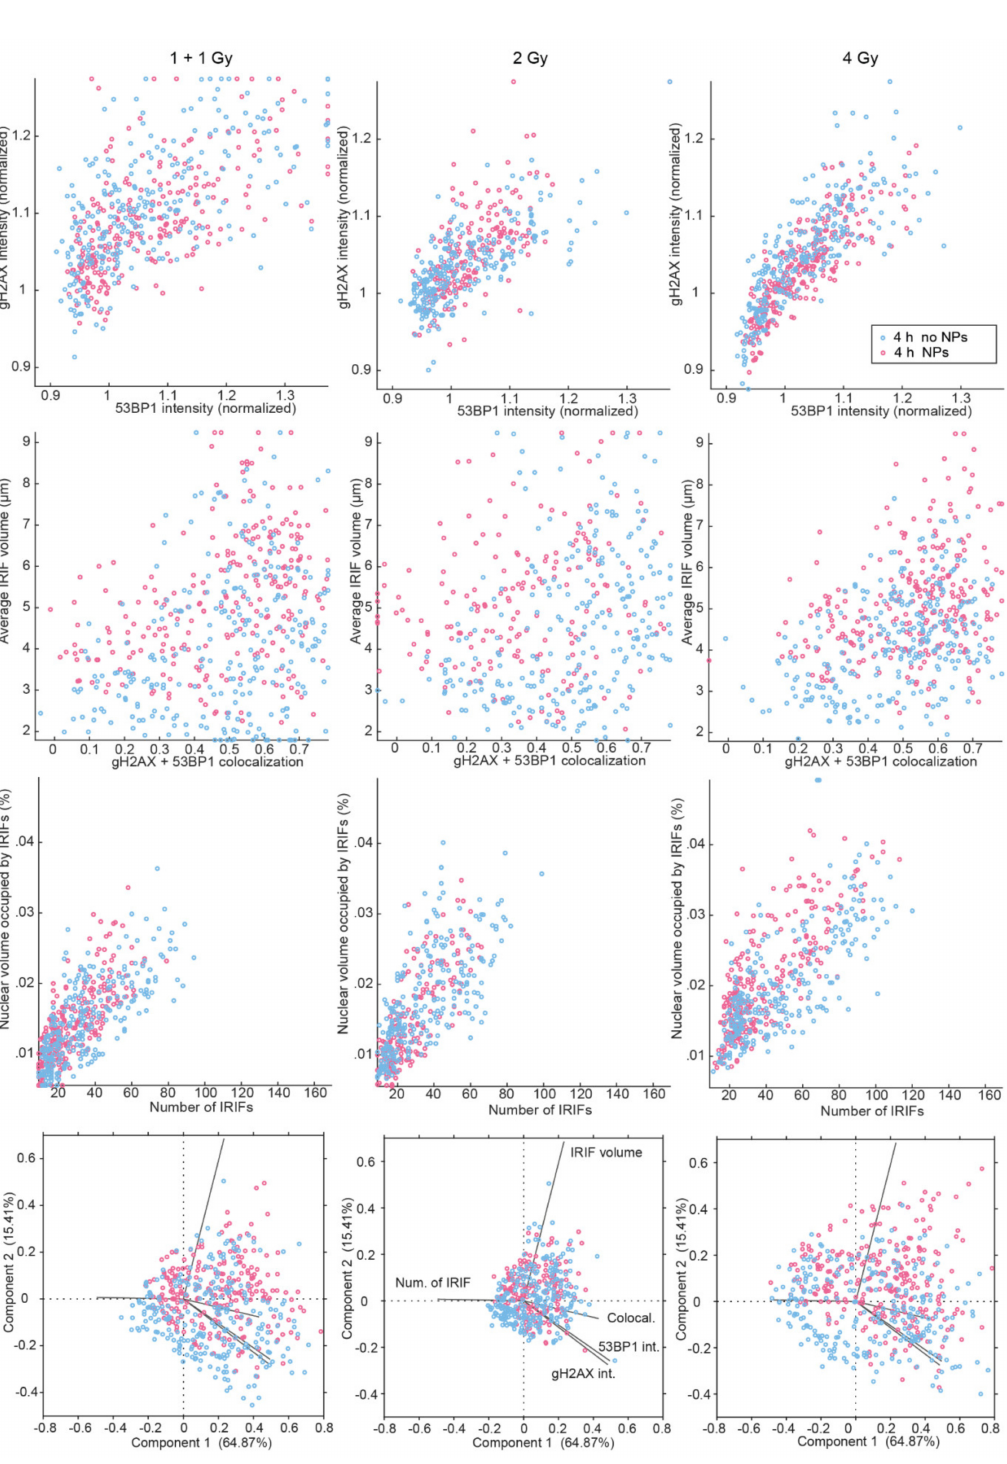
Figure 8. Correlations and principal component analysis (PCA) of multiple γ H2AX and 53BP1 repair focus parameters compared for GNP( − ) ( blue ) and GNP(+) (0.4 µ g/mL, red ) SkBr3 cells irradiated with indicated doses of γ -rays and analyzed at 4 h PI. See the main text for